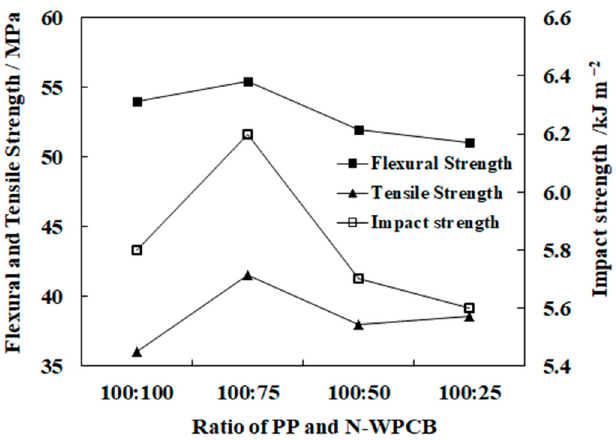
Figure 4. Effect of the PP content of the mixed particles on the mechanical properties of composites.